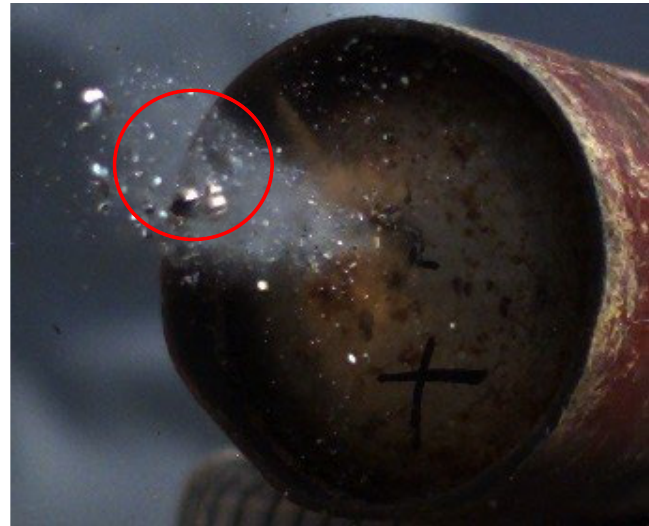
Figure 5. Shooting on the cylinder bottom.